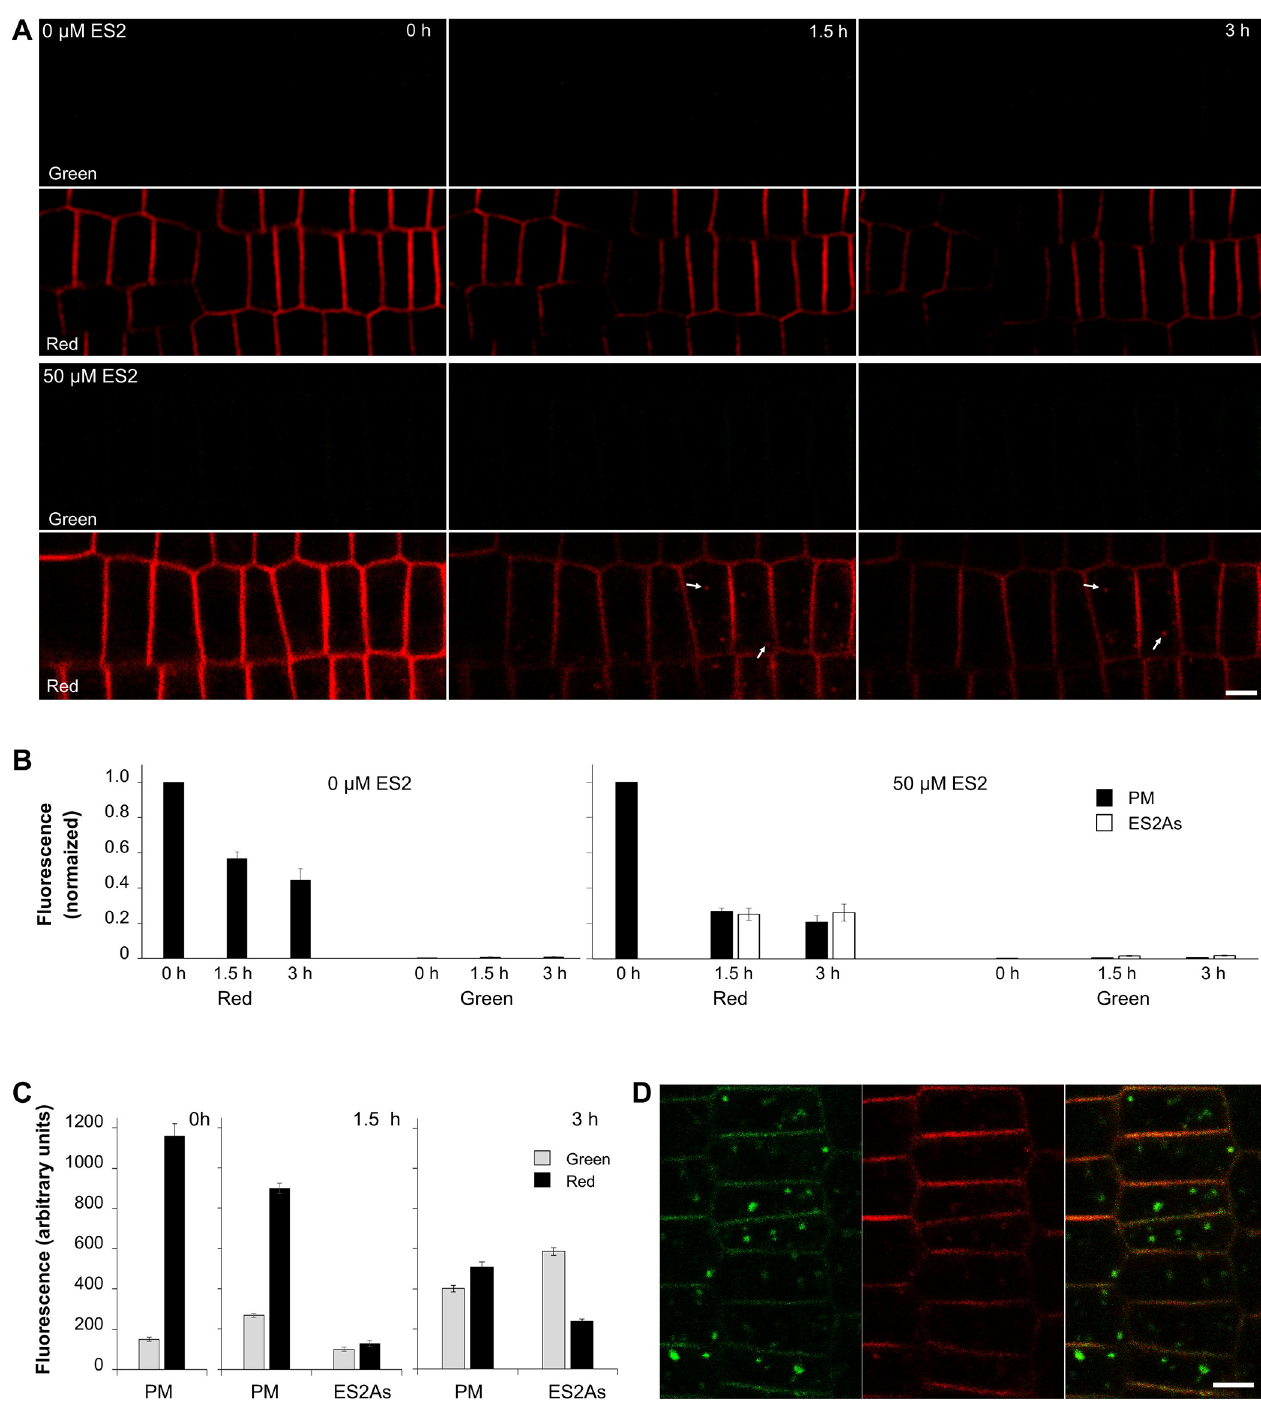
Fig 3. The red PIN2 population in ES2As is of the PM origin. In the presence of 50 μ M cycloheximide, intra-cytoplasmic aggregates contain only the red PM-derived PIN2 population (A). The B charts show the normalized fluorescence intensities of the PM and ES2As. In this experiment, seedlings were pre- treated with cycloheximide for 30 minutes, then photoconverted and placed on the medium with 50 μ M cycloheximide and with or without 50 μ M ES2. Roots were immediately imaged and then reimaged after 90 minutes and three hours. The means of the green signal intensities of the PM and ES2As at each time point were normalized to the mean of green signal intensities of the PM of the same root before photoconversion. Time-points 0 represent the relative green signal intensities recorded immediately after conversion. The means of red signal intensities at each time point during the experiment were related to the mean of red fluorescence intensities of the PM measured immediately after conversion (time-point 0). Values of the time-points 0 were set to 1. Note that ES2As are only detectable in the green channel. In the experiment shown in C and D, seedlings were photoconverted and kept on the standard cultivation medium for